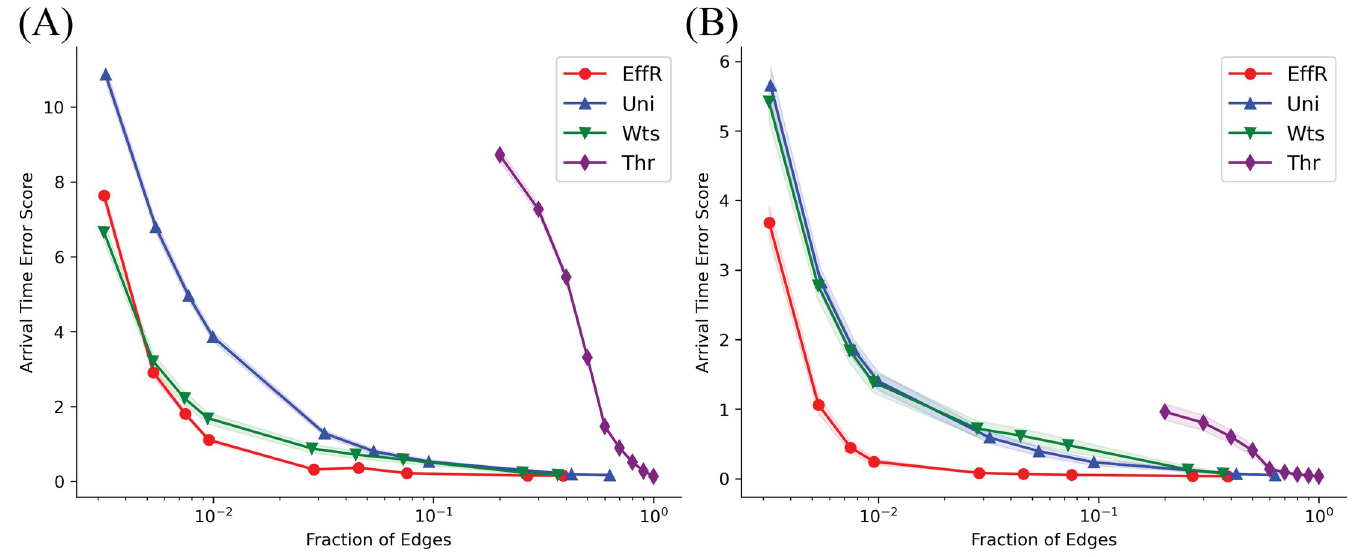
Fig 3. Sparsification of the U.S. mobility network average: Arrival Time Error Score. Arrival Time Error Score averaged over nodes and over 1000 independent simulations for the (A) localized initial conditions and (B) dispersed initial condition. The shaded regions correspond to one standard deviation of the average, which for several of these curves is too small to see. The horizontal axis shows the fraction of distinct edges of the original network preserved by the sparsifier. Note that this fraction is slightly less than q , since edge-sampling algorithms can choose the same edge multiple times.